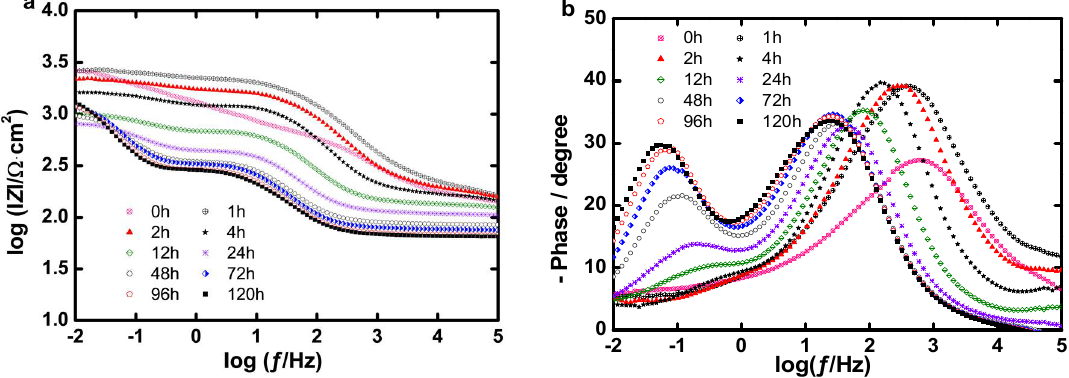
Figure 8. Time evolution of EIS Bode modulus ( a ) and phase angle ( b ) plots for lead coupons coated in a 50 mM NaC 18 solution for 24 h during immersion in a 0.1 M TBAB solution containing 5 µg·L −1 .